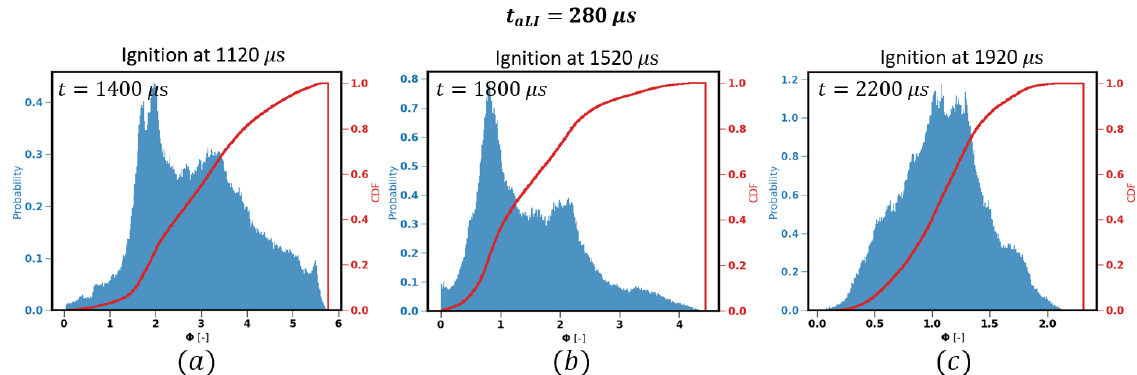
Figure 14. Equivalence ratio distributions consumed by the flame between 280 and 380 µ s after laser ignition (computed in the 3D domain). The red lines show the cumulative distribution function